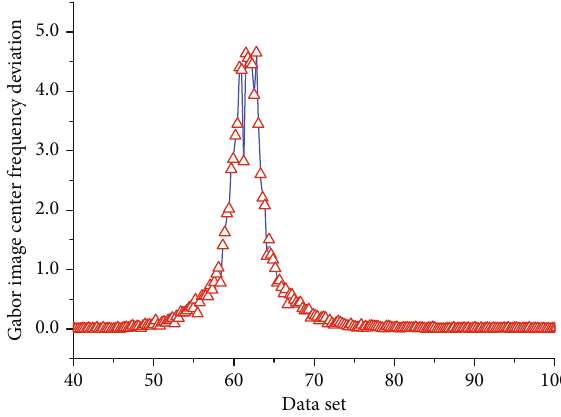
Figure 6: Gabor image center frequency deviation